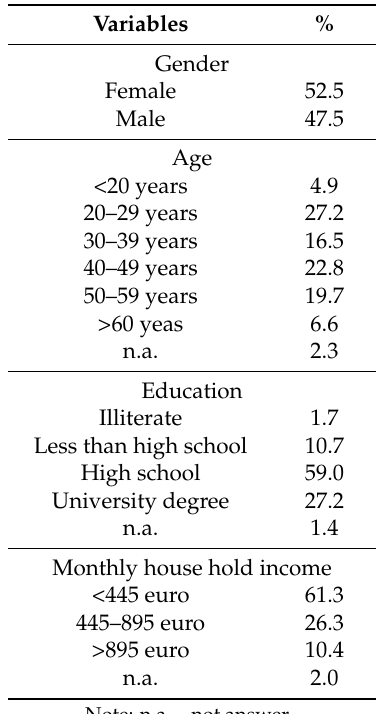
Table 1. Socio-demographic characteristics of the